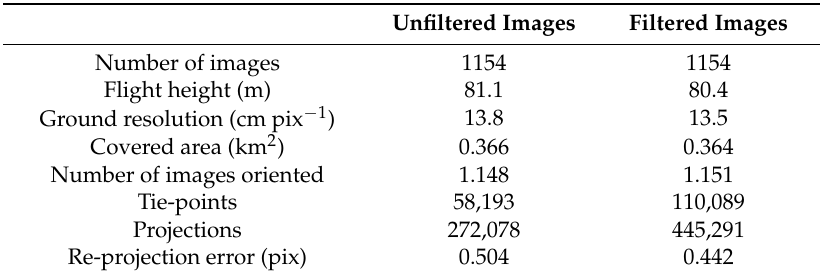
Table 3. Characteristics of each of the photogrammetric procedures performed for each of the described situations.